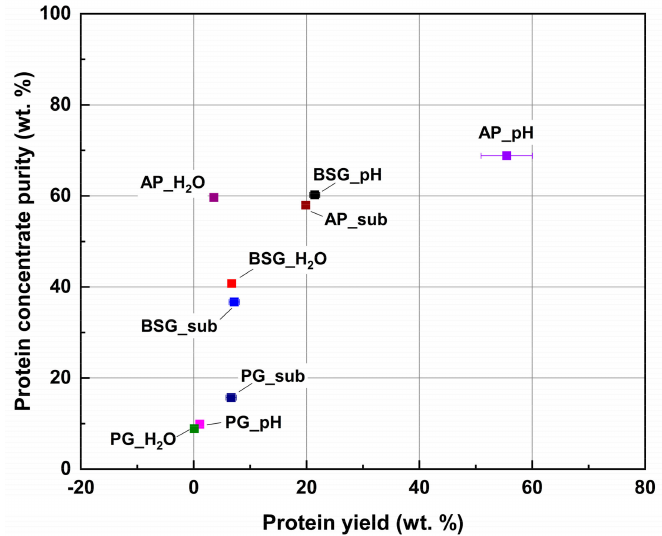
Figure 1. Graphical integration of protein extraction yield and protein concentrate purity.